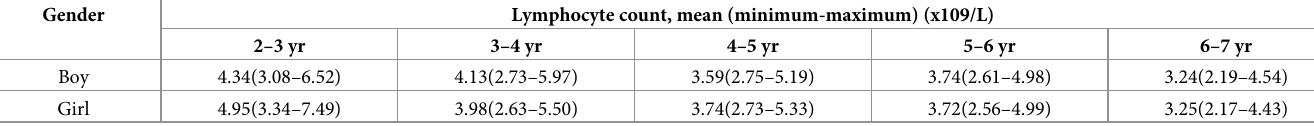
Table 3. Reference intervals of lymphocyte counts in healthy Chinese children reported by Jia LT [8]. Gender